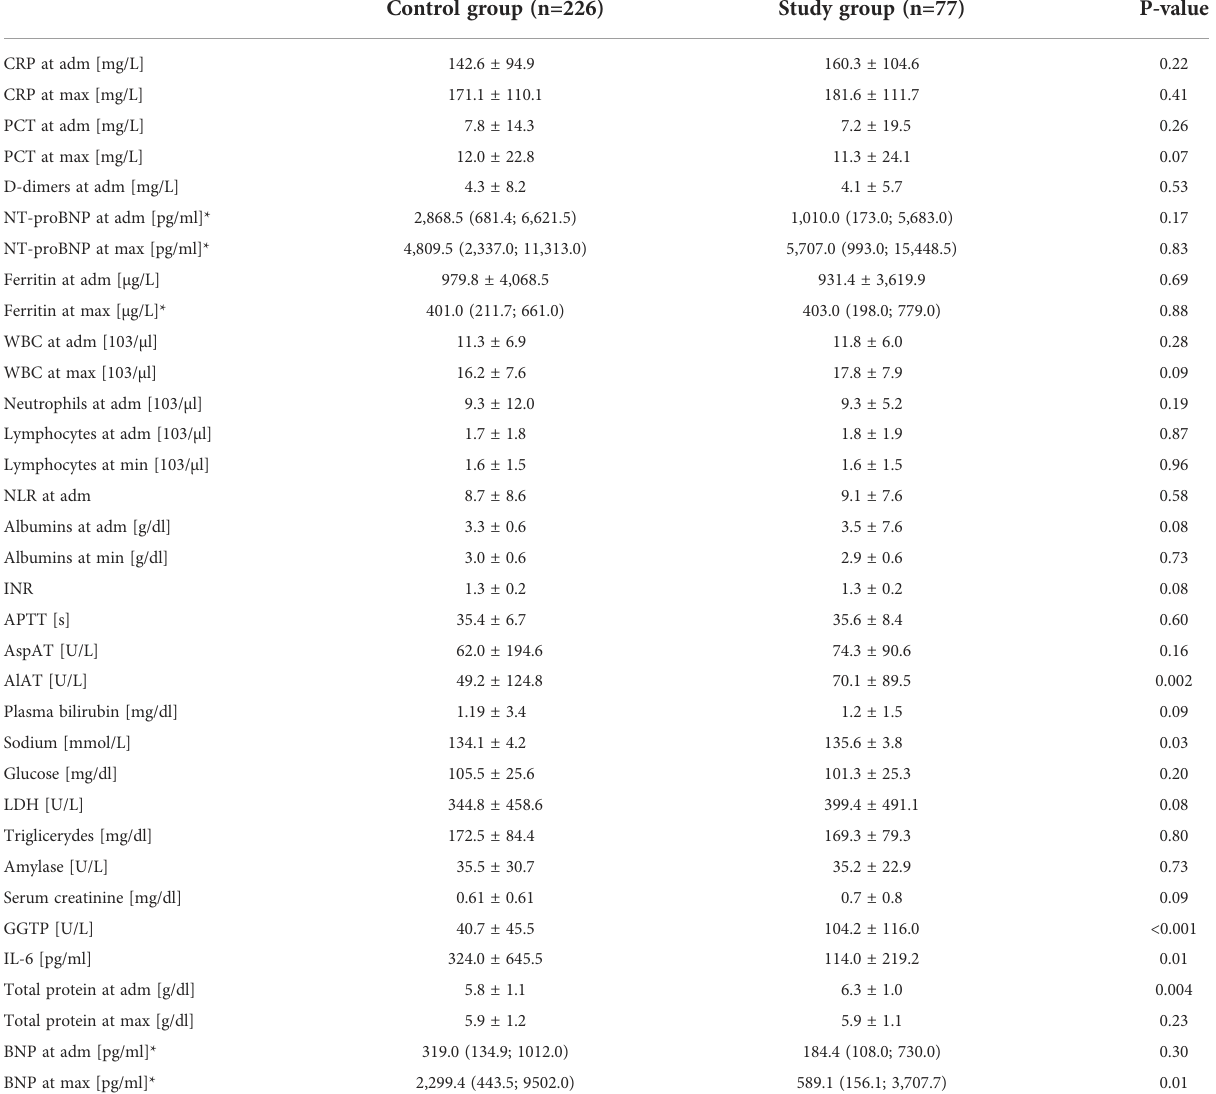
TABLE 4 Comparison of laboratory results between the control and study